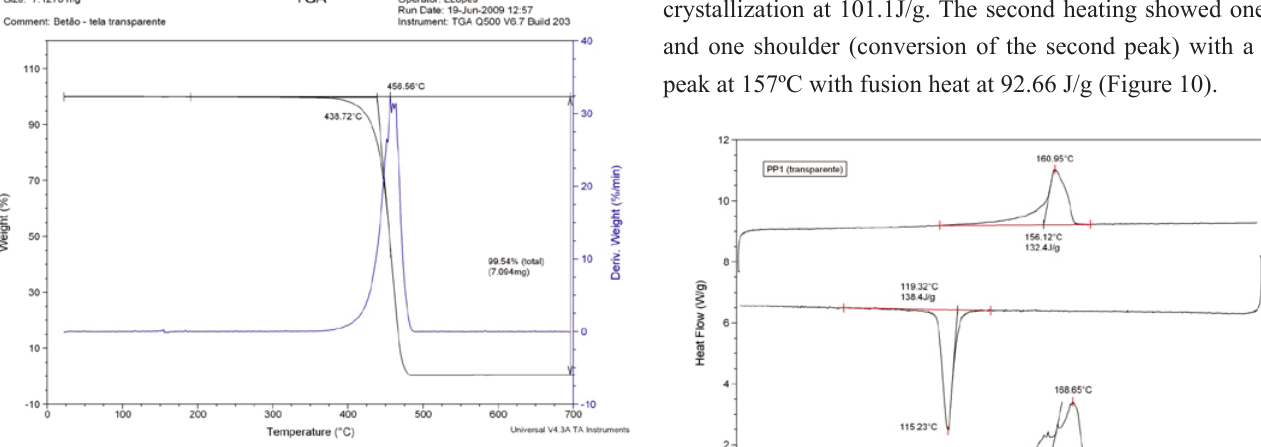
FIGURE 7 - Thermogravimetry of Group 2 showing the beginning of decomposition and the peak value.